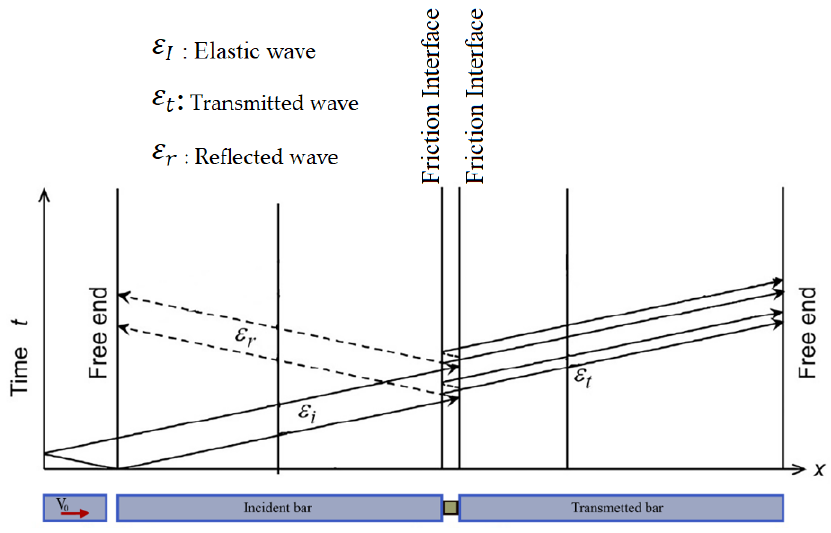
Figure 3. Wave propagation principle, Lagrange diagram.